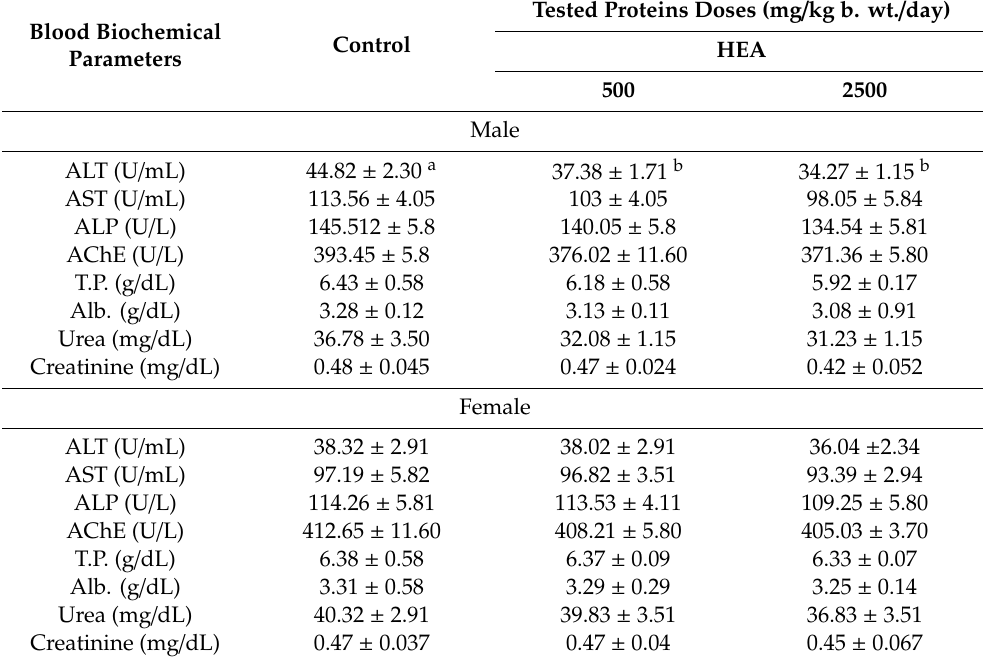
Table 7. E ff ect of hydrolyzed egg albumin (HEA) on blood biochemical parameters of male and female albino rats treated orally daily for 28 days.